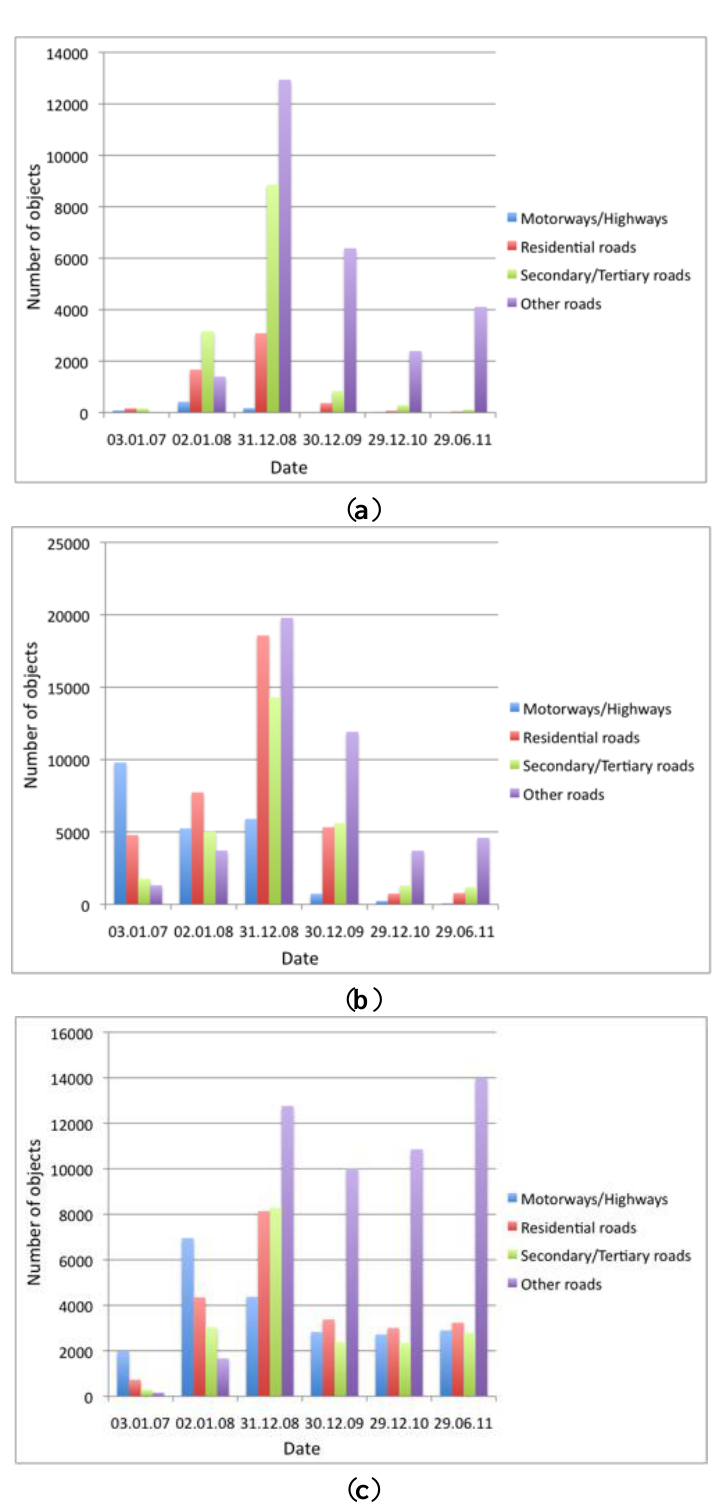
Figure 13. ( a ) OSM Topology Errors; ( b ) OSM Duplicate Nodes or Ways Errors; ( c ) Lack of Information